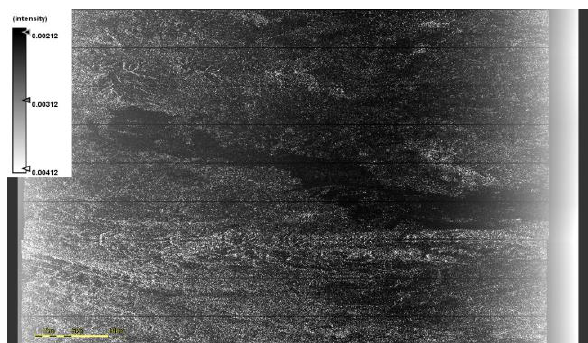
Figure 4. Re-introduced Thermal Noise Map